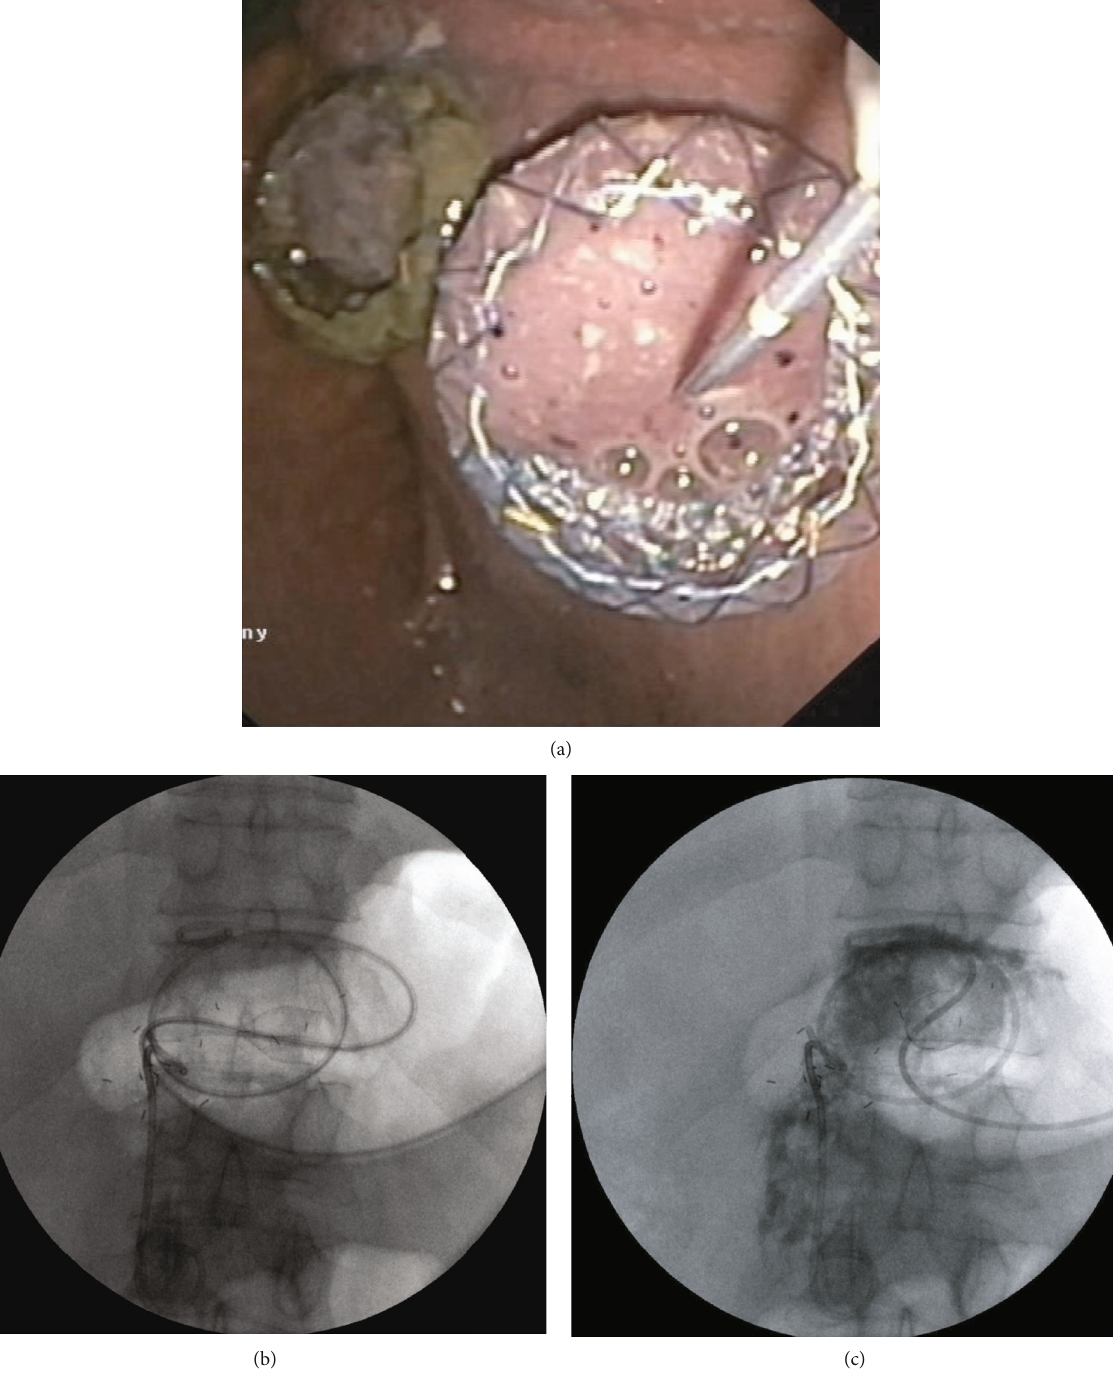
Figure 9: (a – c) MTGT using two LAMS in infected WOPN